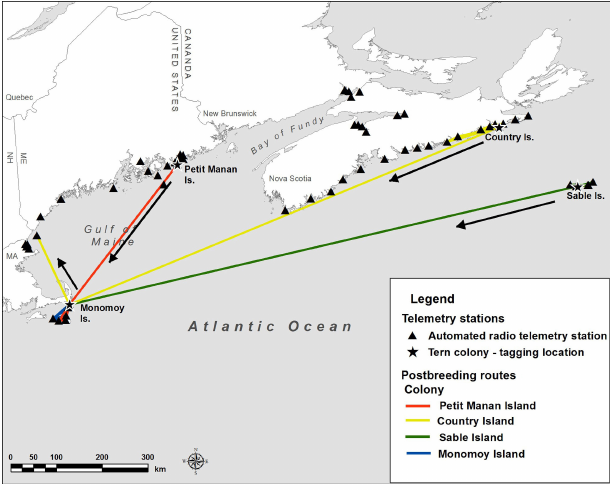
Fig. 2 . Euclidian postbreeding movements of tagged Common Terns ( Sterna hirundo ; n = 120) from four nesting colonies in the northwest Atlantic, Petit Manan Island, Maine, USA (red); Country Island, Nova Scotia, Canada (yellow); Sable Island, Nova Scotia, Canada (green); and South Monomoy Island, Massachusetts, USA (blue), tracked by 62 automated radio telemetry stations during the 2013 postbreeding dispersal period. Black arrows show generalized direction of